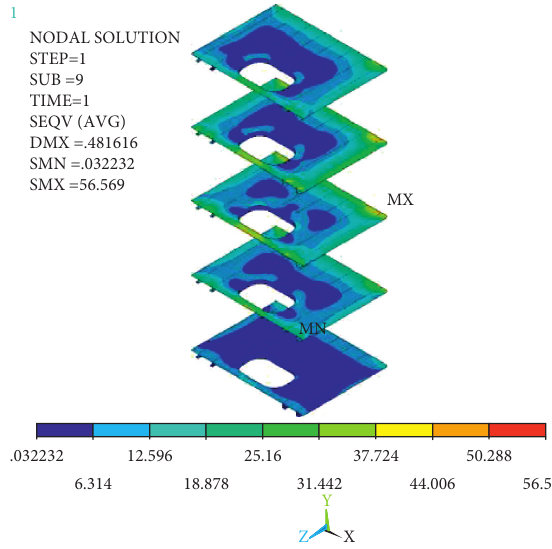
Figure 13: von Mises stress distribution of the diaphragm (MPa).